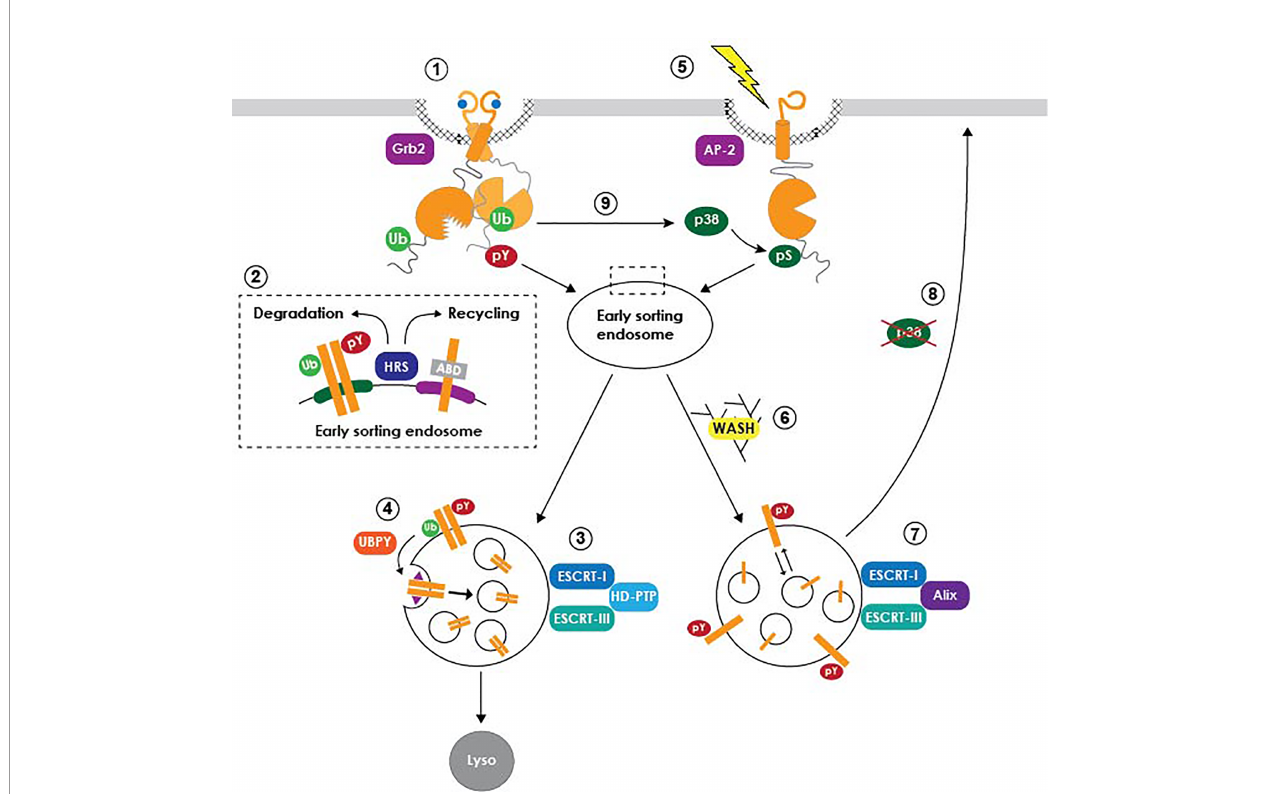
FIGURE 1 | Model summarizing EGFR traf fi cking pathways. Ligand-activated receptors are internalized from clathrin-coated pits via an interaction with Grb2 (1), and subsequently diverted away from a constitutive actin-dependent recycling pathway through their recognition by HRS and other early ubiquitin-binding ESCRT subunits (2). Degradative MVB sorting is regulated by a subset of the ESCRT machinery (3), including accessory proteins such as UBPY that facilitate EGFR transfer from ubiquitin-binding ESCRT machinery to ESCRT-III (4). A putative retention factor (purple triangle) restrains EGFR from being diverted away from nascent ILVs to the ubiquitin-independent recycling pathway. Stress-exposed EGFRs are internalized via a p38-MAPK-dependent interaction with the AP-2 clathrin adaptor (5), followed by sustained signaling in non-degradative MVBs via a mechanism requiring WASH (6) and Alix (7). Stress-exposed EGFRs subsequently recycle back to plasma membrane following p38-MAPK inactivation (8). Ligand-activated EGFR signaling also regulates endocytic traf fi cking of unliganded receptor monomers downstream of non-canonical p38-MAPK-dependent phosphorylation. It is not currently known if this pathway involves the same non-degradative MVB sorting mechanism described for stress-exposed